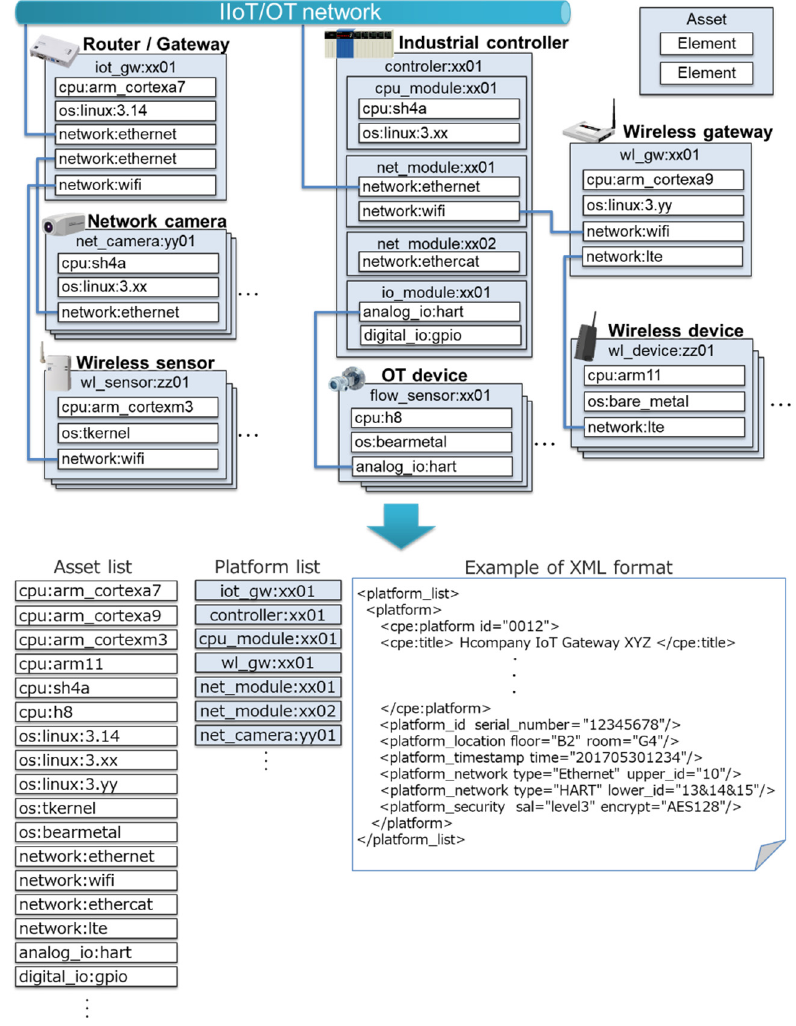
Figure 3. Example of IIoT system structure.